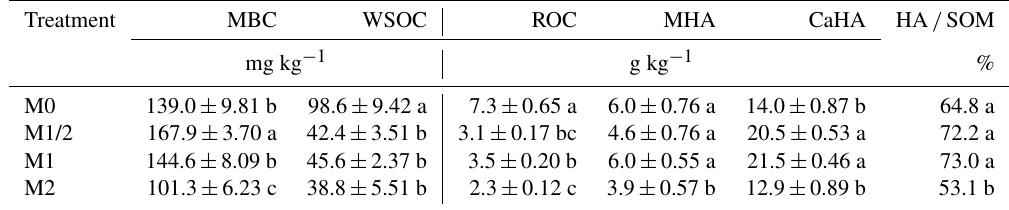
Table 3. Effect of different mowing managements on bulk SOM fractions. Treatment